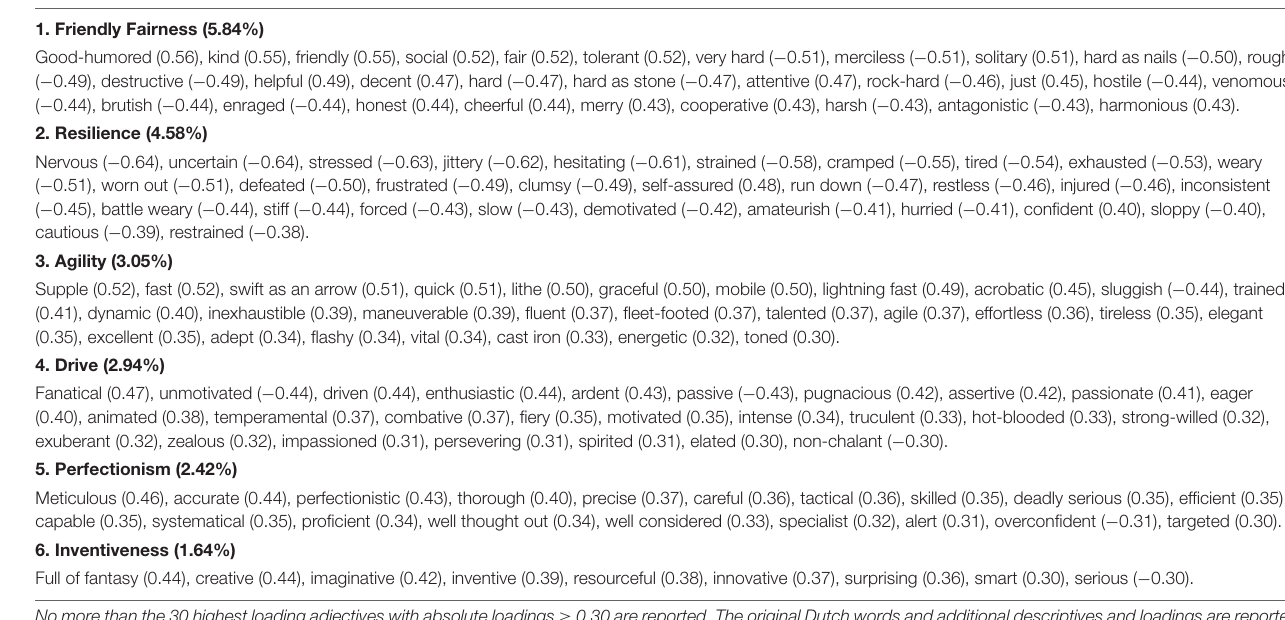
TABLE 2 | Highest loading adjectives in the six varimax rotated PC